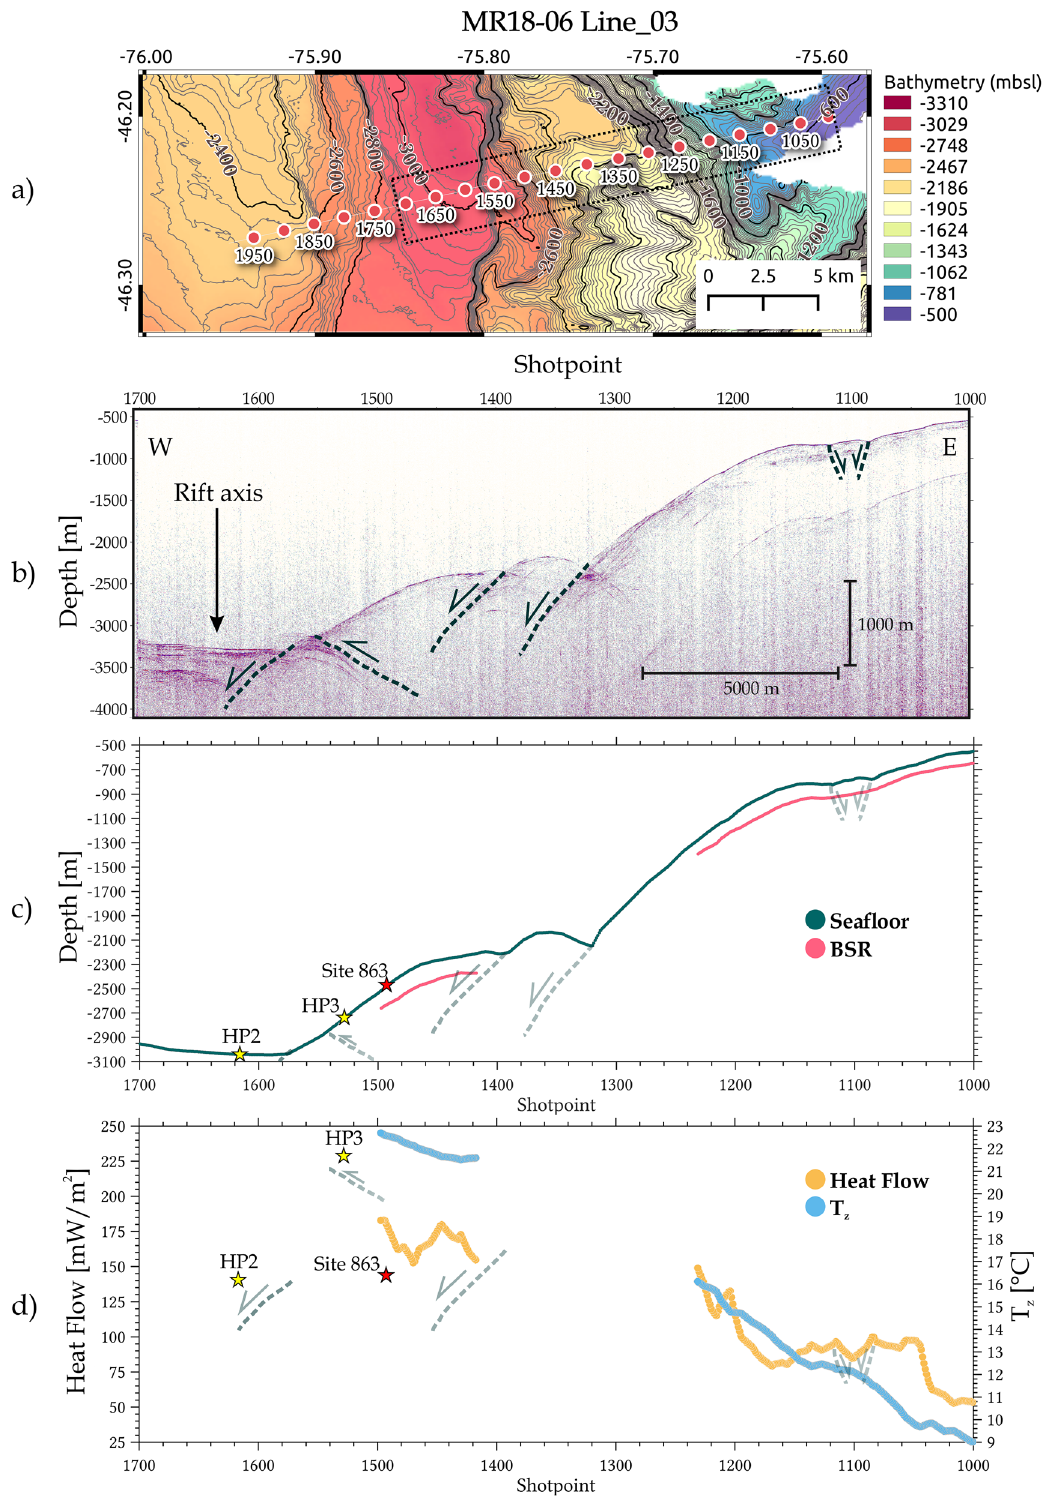
Figure 6. BSR-derived heat flow results from the MR18-06-Line_03 profile: ( a ) location of the seismic profile, red dots indicate the shotpoint values of the Line_03. Dashed rectangle indicates the plotted area in the panels ( b – d ). Figure generated using QGIS-v3.16.8 (https:// www. qgis. org/ en/ site/); ( b ) imaging of the cross seismic section; ( c ) seismic horizons identified for the seafloor (dark green) and the BSR (pink); ( d ) calculated heat flow (orange) and temperature at the BSR T z (sky blue) based on assumed lithostatic pressure. Stars indicate the location ( c ) and value ( d ) of the direct heat flow measurements along the